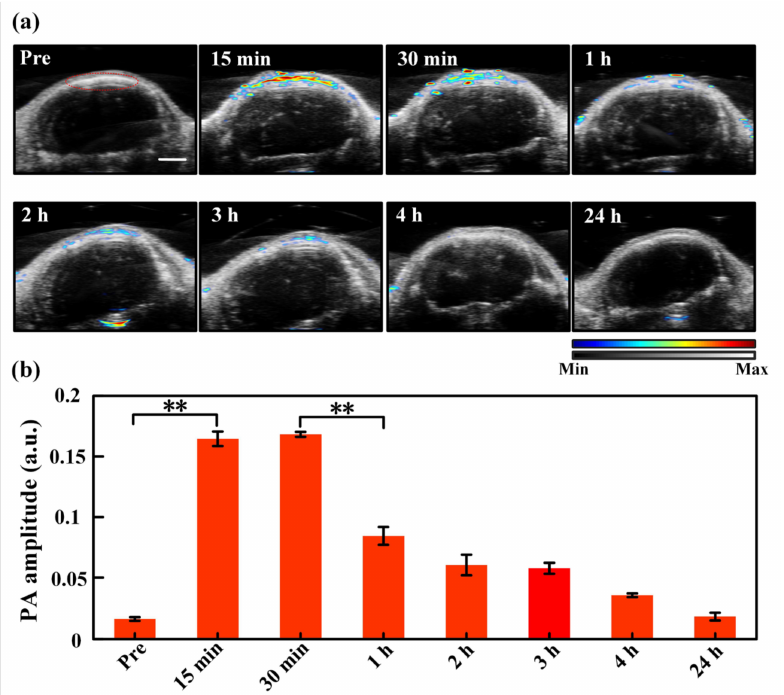
Figure 3. ( a ) Ultrasound (the grey background) and PA (the colored values) images of the tumor region with time pre and post injection. The region encircled by the red curve in the “Pre” picture is the region of interest (ROI) used for data analysis, which is identical for all images acquired at different time moments. The color bar indicates the intensities of PA/US signals. ( b ) Quantitative PA amplitude of ICG signals (spectral unmixing) in the tumor region at different time points after injection. **, p < 0.01 (tested by Student’s two-tailed, unpaired t -test). The error bars in ( b ) are standard deviations. Scale bar: 2